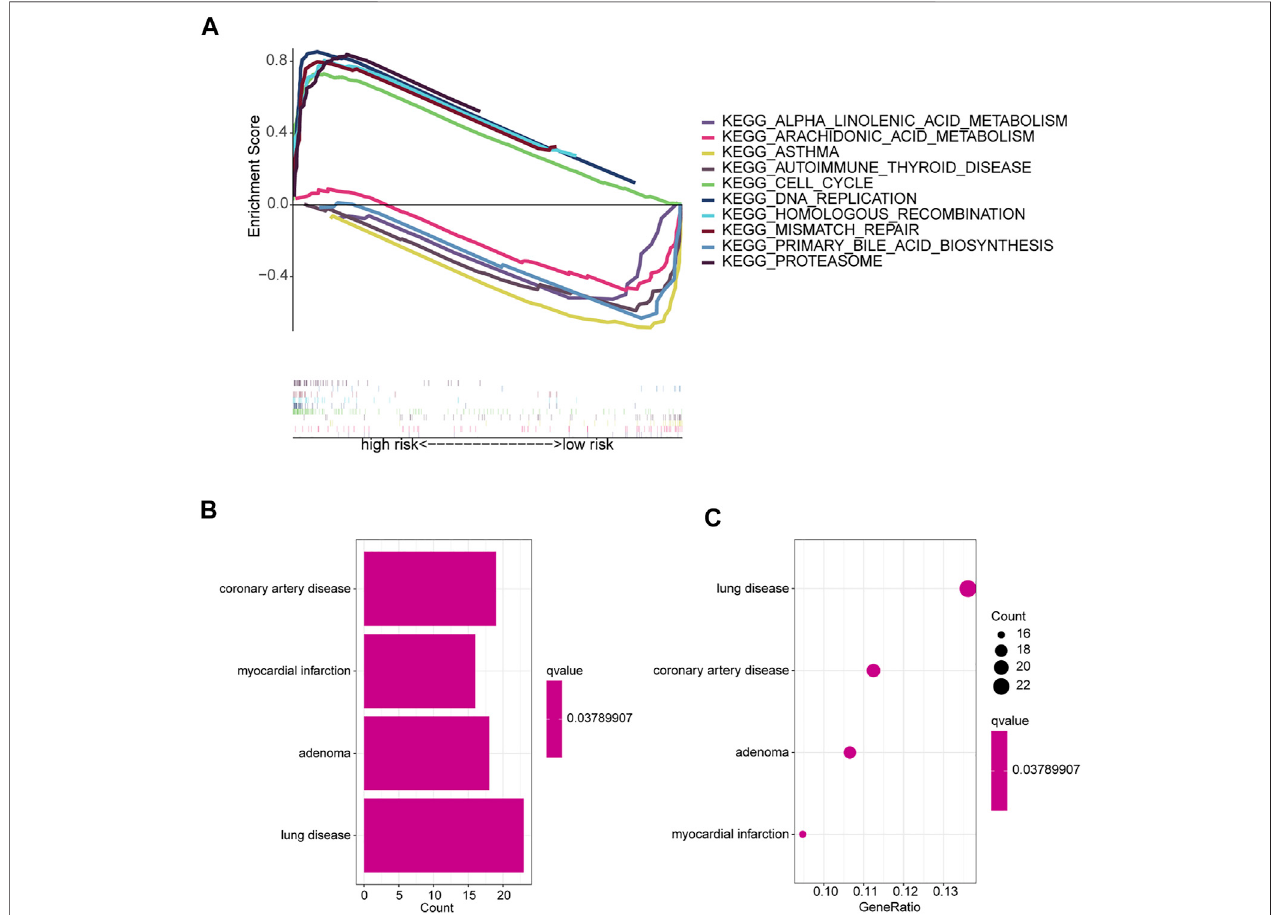
FIGURE 6 | Enrichment analysis of different risk subgroups. (A) Five pathways were signi fi cantly enriched in each of the high-risk and low-risk groups. (B,C) DO enrichment analysis of DEGs based on different risk subgroups.